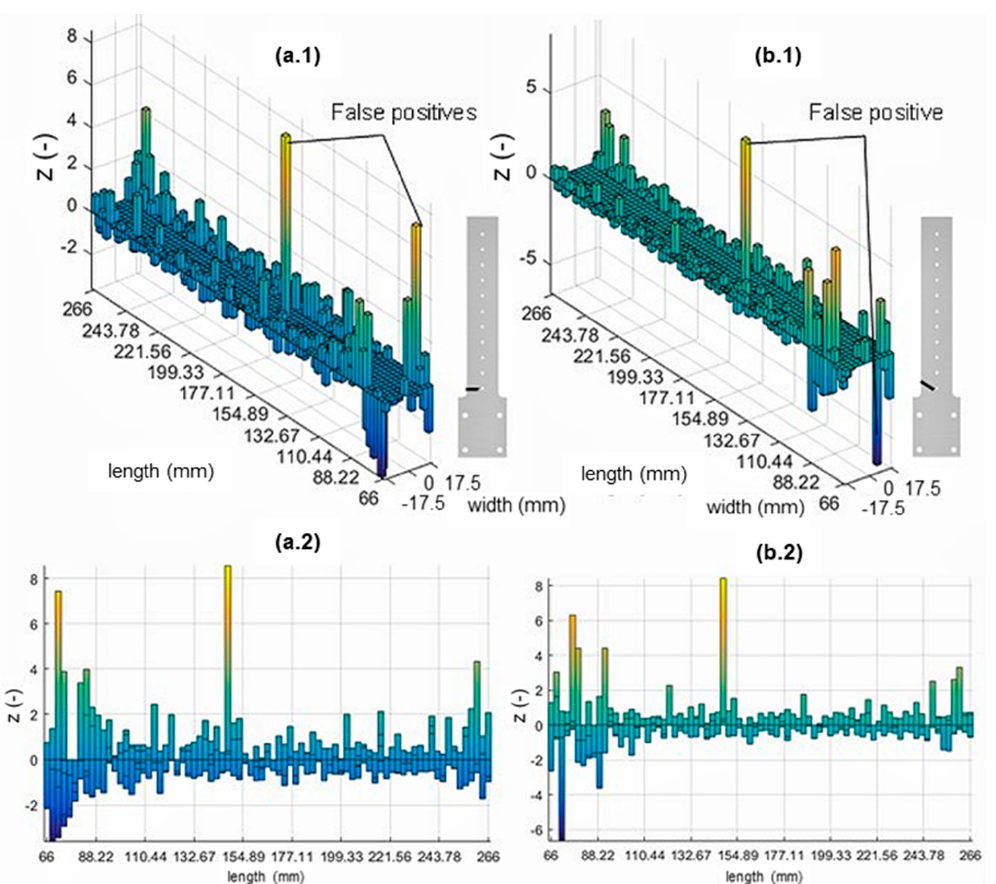
Figure 7. MSE-DI implementation to simplified ABS sample (skin only): ( a.1 , a.2 ) 0° cracked and ( b.1 , b.2 ) 30° cracked samples.